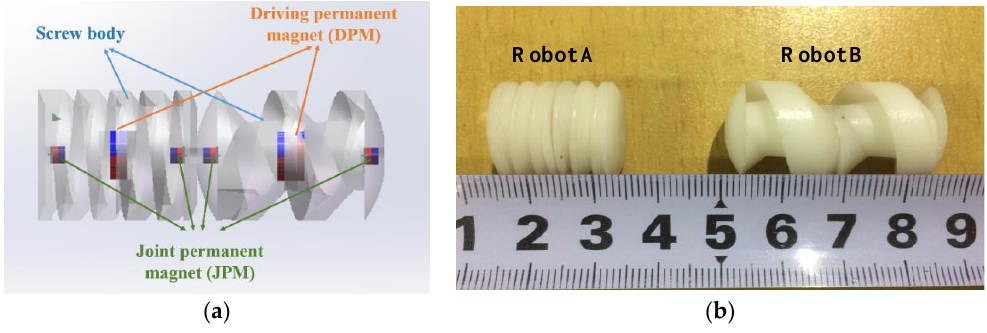
Figure 2. Design of multiple capsule robots: ( a ) schematics of multiple capsule robots; ( b ) prototype of multiple capsule robots.